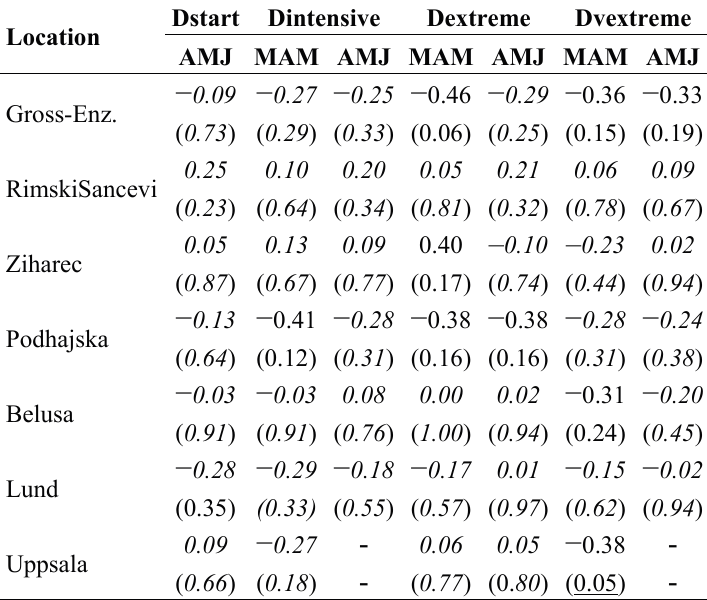
Table 13. Correlation coefficients and p values (in brackets, underlined values are significant) between AMI describing number of dry days and RDSY for WW relative to observed value. No effect: 38 of 49 ; with effect: 0 out 49 . Location